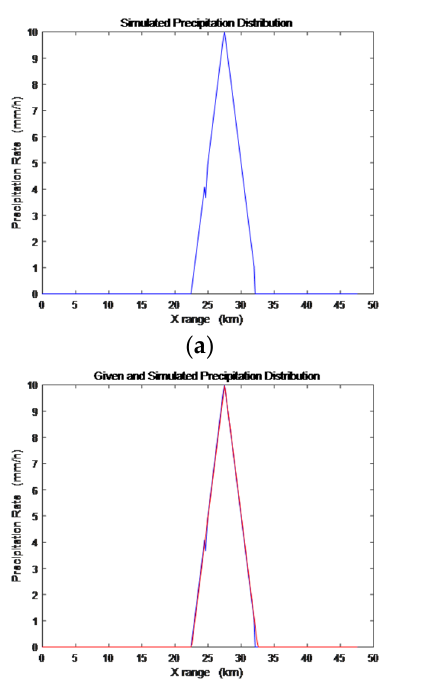
Figure 3. Trapezoidal distribution diagrams for 𝑅(𝑥) = 10 mm/h . ( a ) Given precipitation distribution; ( b ) Simulated precipitation distribution; ( c ) Given precipitation distribution and simulated precipitation distribution; ( d ) Relative error between given and simulated result.